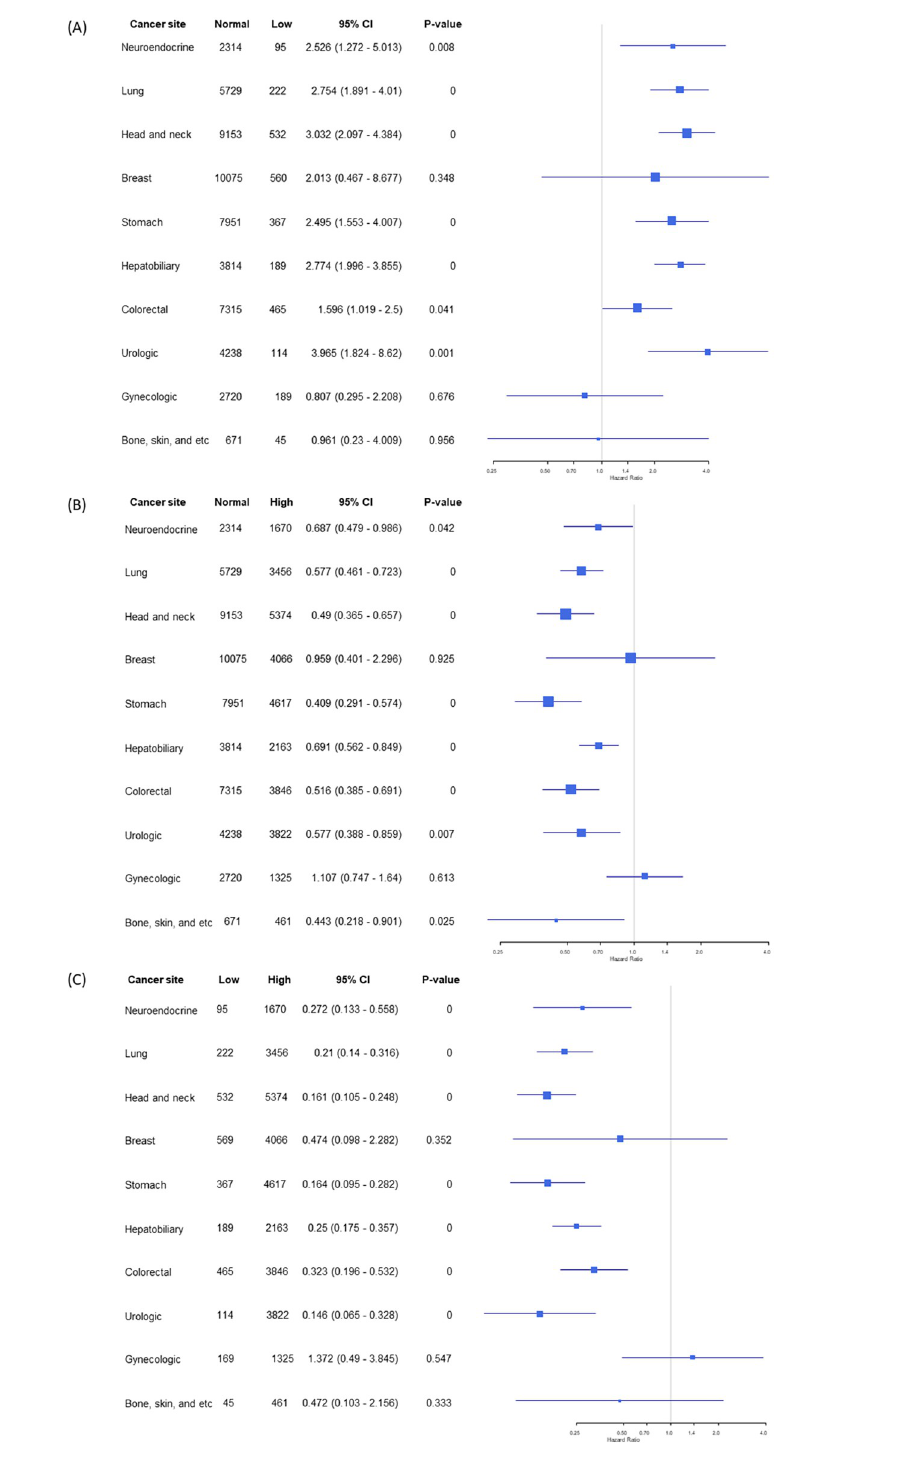
Fig 4. Subgroup analysis according to cancer sites in (a) normal vs. low BMI groups, (b) normal vs. high BMI groups, and (c) low vs. high BMI groups comparisons.